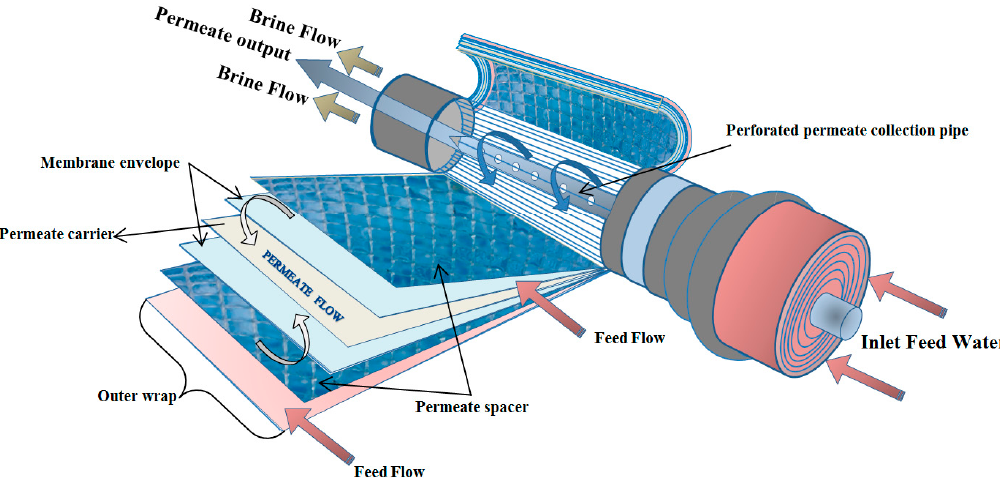
Figure 3. Schematic diagram of a spiral wound (SW) membrane element (Adapted from Additive. Manufacturing, 2020) [21].